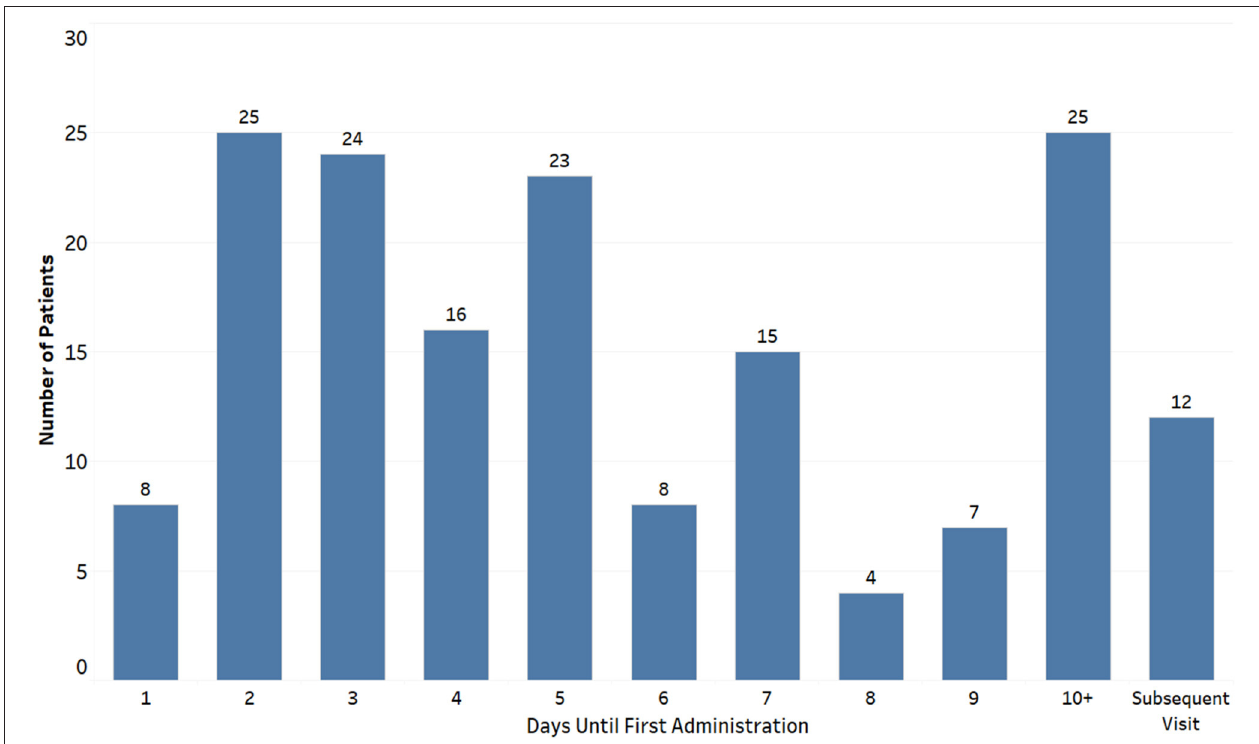
FIGURE 3 | Day of eculizumab administration after index hospitalization among children with hemolytic uremic syndrome receiving eculizumab therapy ( n = 167).